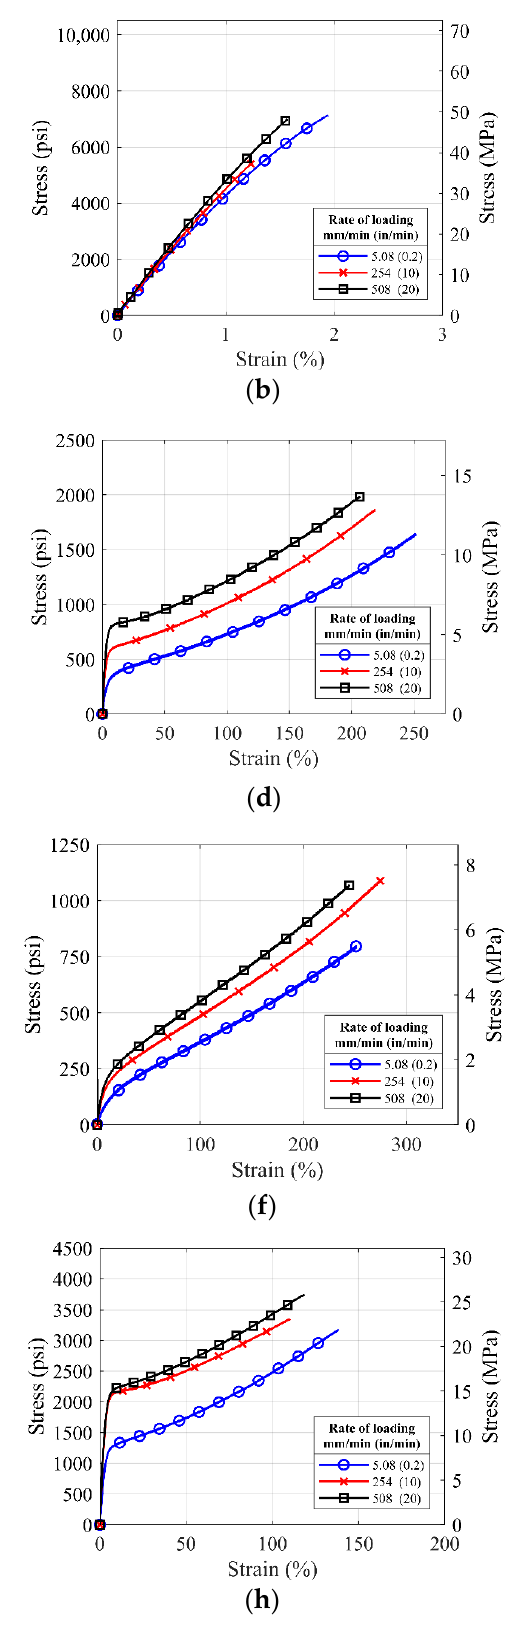
Figure 8. Average stress-strain curves for ASTM die type IV coupons of ( a ) S1, ( b ) S2, ( c ) S3, ( d ) S4, ( e ) S5, ( f ) S6, ( g ) S7, and ( h ) S8 material tested with loading rates of 0.2 in/min, 10 in/min and 20 in/min.